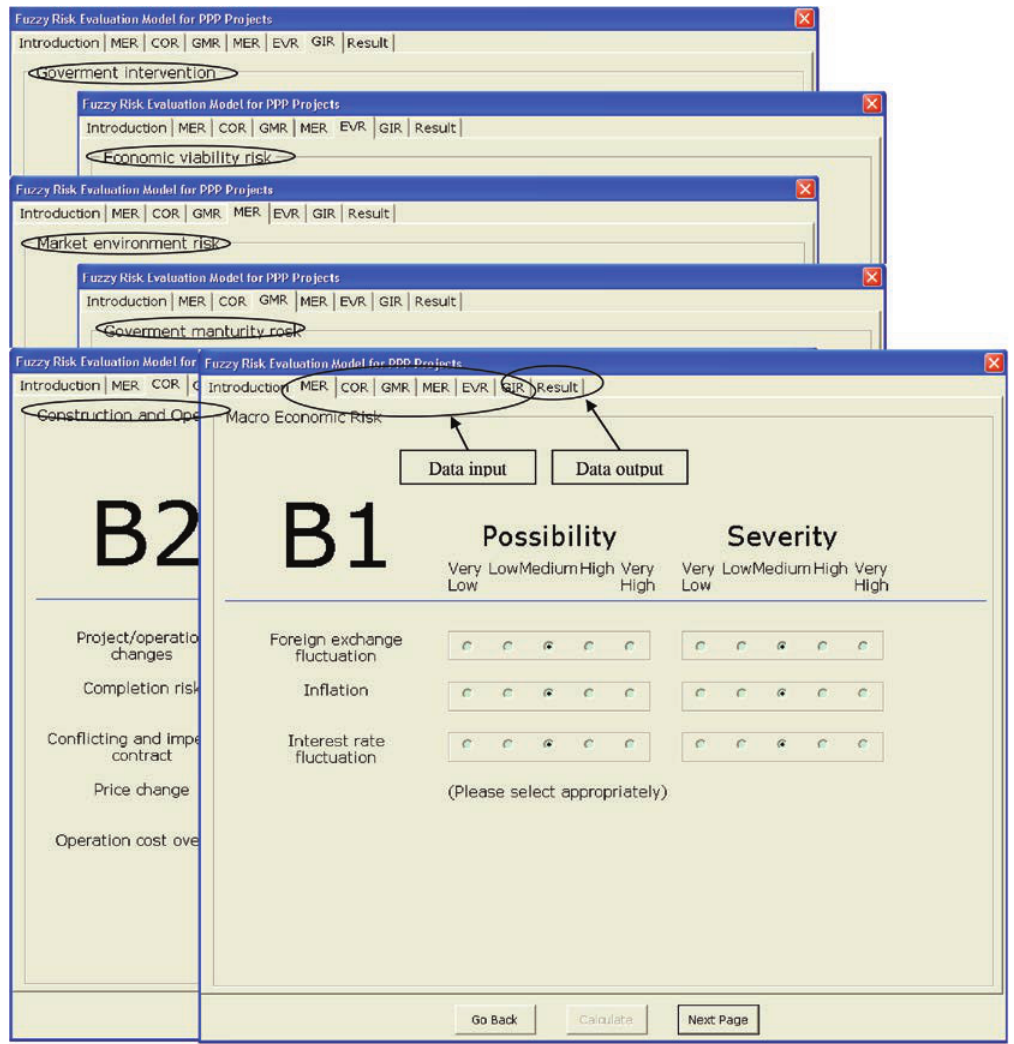
figure 4. Data input format of the risk evaluation